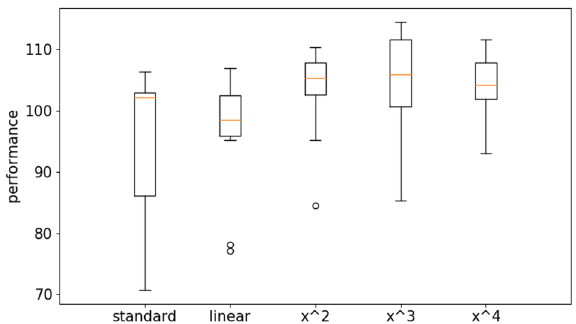
Figure 7. Performance of the agents evolved with the OpenAI-ES algorithm on the bipedal hardcore problem with the standard and the curriculum learning version of the algorithm. For the latter the figure reports the results obtained with the linear difficulty function (linear) and a power function with exponential 2, 3 and 4 (x 2 , x 3 , and x 4 ). Each boxplot shows the results obtained in 10 replications. Boxes represent the inter-quartile range of the data and horizontal lines inside the boxes mark the median values. The whiskers extend to the most extreme data points within 1.5 times the inter-quartile range from the box.